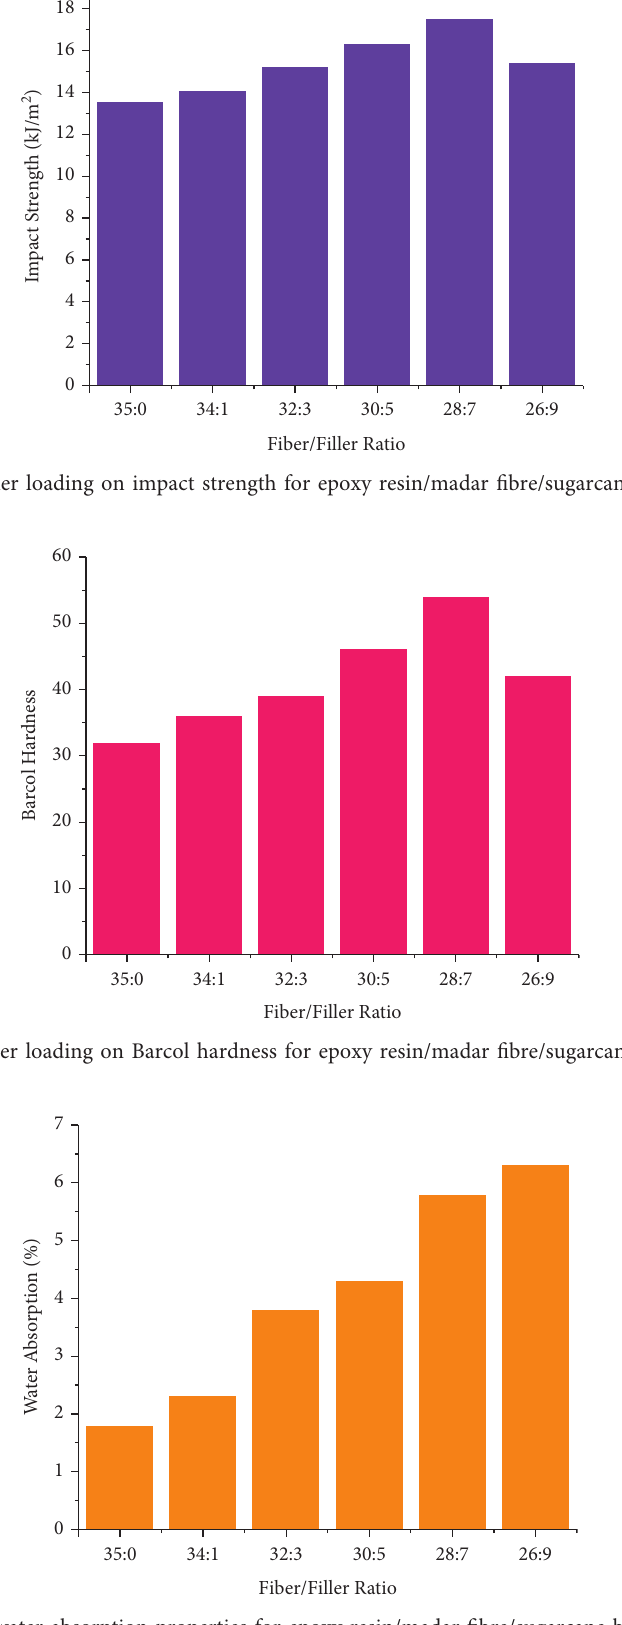
Figure 13: Variation of water absorption properties for epoxy resin/madar fibre/sugarcane bagasse ash